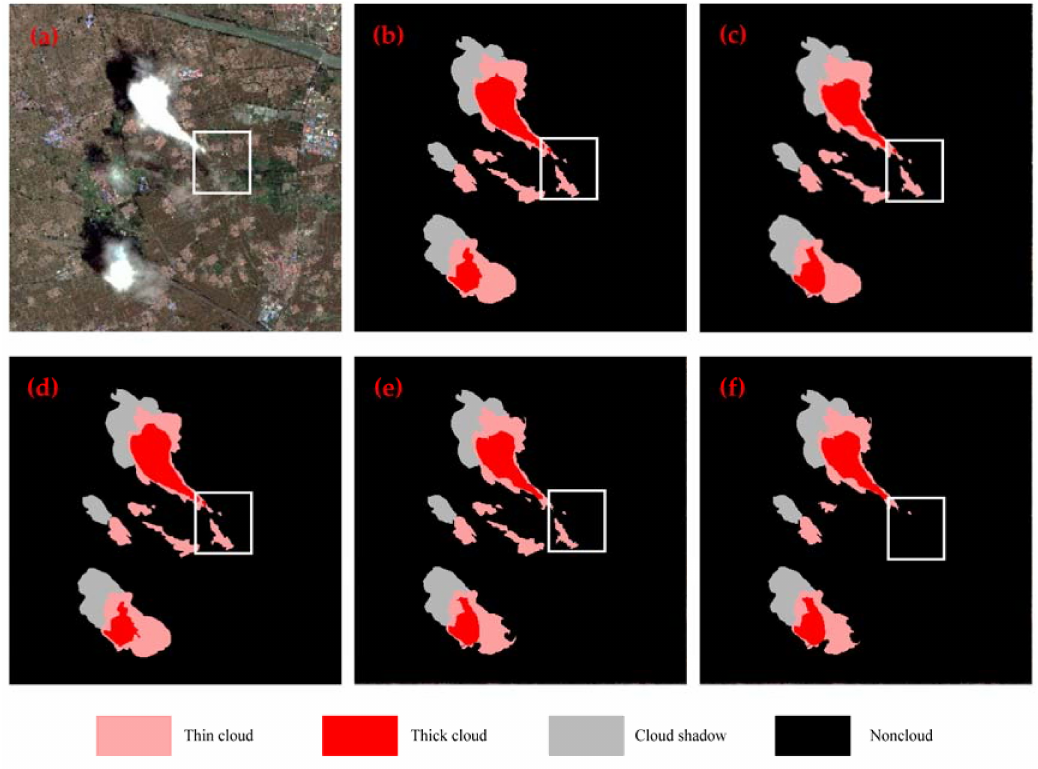
Figure 9. Multilevel cloud detection results using different CNN architectures: ( a ) original image; ( b ) ground-truth image; ( c – f ) our proposed approach, SAP + MCNNs, MP + MCNNs, and AP + MCNNs,